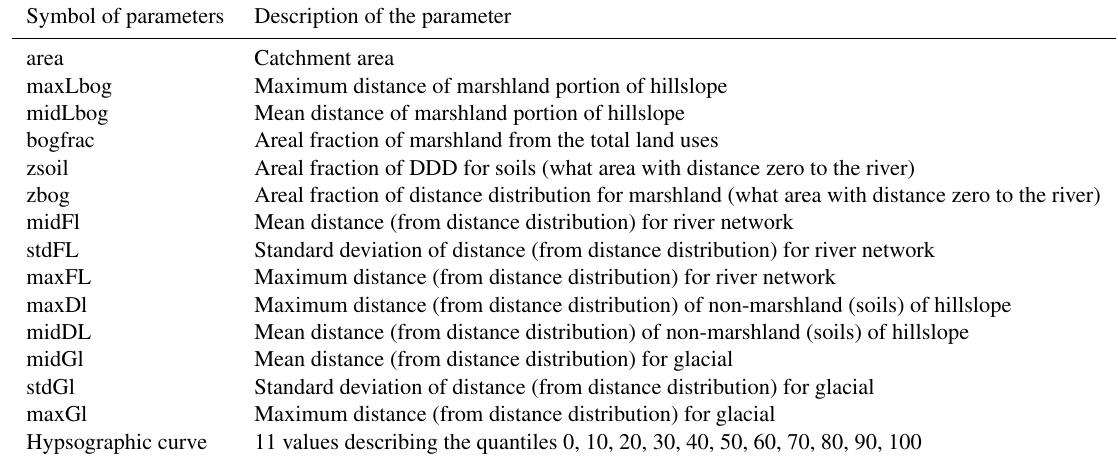
Table A3. List of DDD rainfall–runoff model parameters estimated from geographical data using GIS. Symbol of parameters